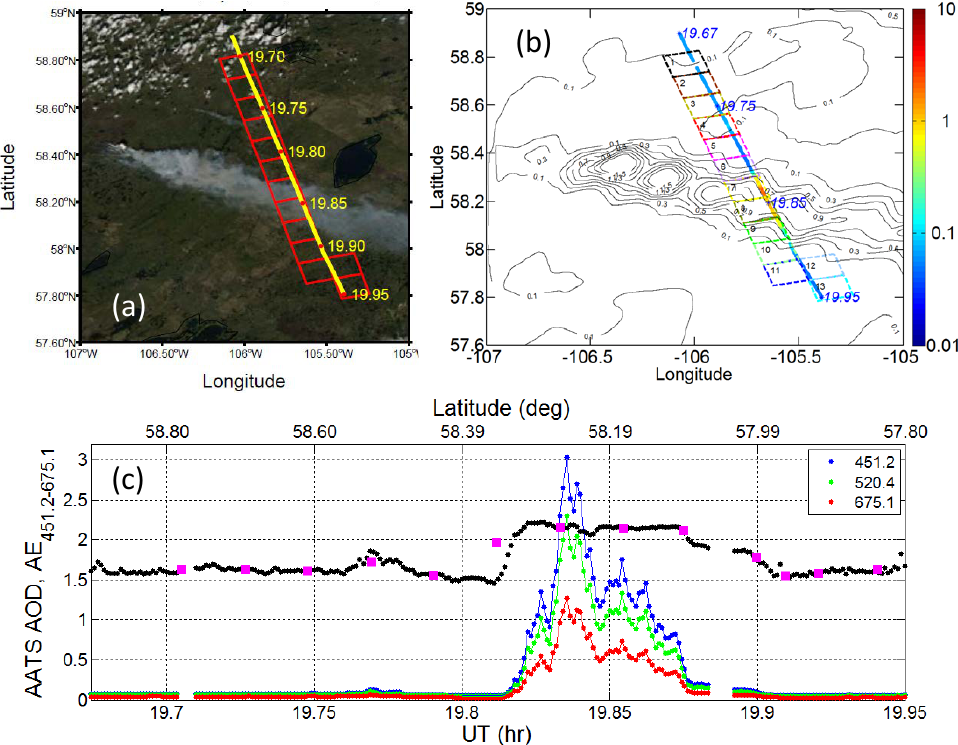
Figure 1. (a) Aqua MODIS RGB image for the overpass at 19.85 UT on 30 June 2008. Locations of the MODIS 10-km resolution aerosol retrieval grid cells (red) and the P-3/AATS-14 flight track (yellow) are overlaid. Yellow numbers give UT along the P-3 flight track. (b) Overlay of MODIS grid cells (color-coded for comparison with AATS AOD spectra in Fig. 3) and P-3 track (color-coded by AATS 520-nm AOD) on contour map of MODIS AOD retrieved at 10-km resolution with the aerosol cloud mask and the NDVI mask turned off. Cells are numbered from NW to SE. (c) Time and latitude series of AATS AOD (colors) and Angstrom exponent (AE, black) along the P-3 flight track; magenta squares show mean AATS AE calculated for AATS measurements within individual MODIS 10-km grid cells.